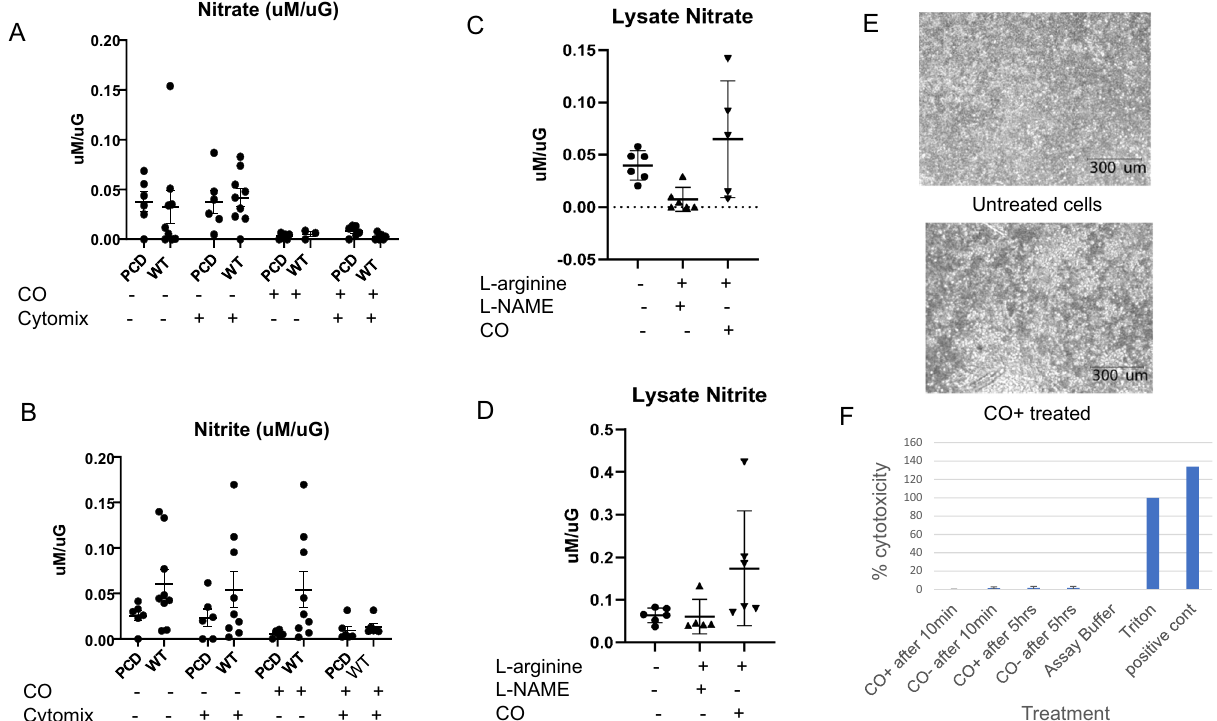
Figure 6. Carbon monoxide (CO) prevents NO oxidation in human primary airway epithelial cell culture medium but does not affect cell viability or NOS activity. ( A ) Nitrate accumulation in the extracellular medium did not differ between subjects (PCD vs wt, p = NS for each pair-wise comparison). Surprisingly, cytomix (10 ng/ uL each of TNFα, IFNγ and LPS for 4 h) did not increase NO 3 − in these primary pseudostratified ALI cultures, in contrast to previous reports from our group and others 20,21 regarding submerged cell lines. This argues against iNOS being the principal source of nitrogen oxides in this system. However, CO (1 ppm; 10 min) completely inhibited NO 3 − production overall (n = 21 positive vs n = 30 negative, p < 0.001). For the pair-wise comparisons, the inhibition effect of CO was significant in PCD without cytomix ( p = 0.001, Tukey p = 0.002) and WT with cytomix ( p < 0.001, Tukey p < 0.001) after Tukey’s multiple correction; was significant in PCD with cytomix before Tukey’s correction ( p = 0.017, Tukey p = 0.067), and insignificant in WT without cytomix ( p = 0.355, Tukey p = 0.827). ( B ) Carbon monoxide (as above) also inhibited NO 2 − accumulation in the medium (4 h, as